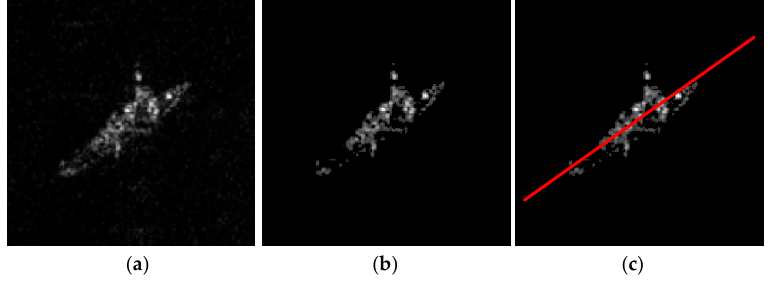
Figure 3. The procedure of classification algorithm. Diagram of the principal axis extraction. ( a ) The original image; ( b ) The segmented image; ( c ) The principal axis extraction.